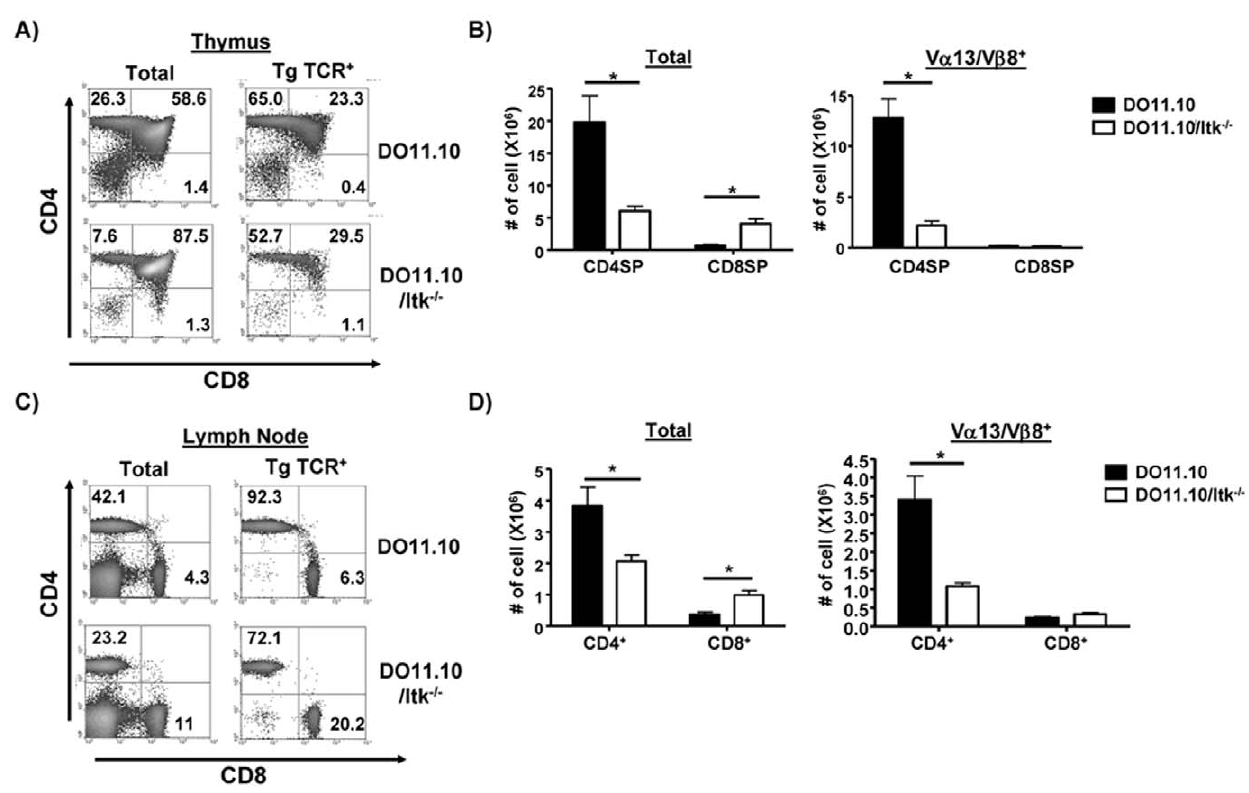
Figure 4. The absence of Itk affects the development of CD4 + T cells in DO11.10 transgenic mice. ( A ) Total thymocytes (left panels) or the transgenic TCR + (KJ-11 + ) population from DO11.10 and DO11.10/Itk 2 / 2 mice analyzed for expression of CD4 and CD8 (right panel). ( B ) The number of thymocytes (total, left) or transgene TCR hi thymocytes (right) in WT and Itk 2 / 2 mice. *p , 0.05, n=3–5 mice. ( C ) Total lymphocytes (left panel) or the transgenic TCR + population (right panel) from cervical lymph nodes of DO11.10 and DO11.10/Itk 2 / 2 mice analyzed for expression of CD4 and CD8. (D) The number of total lymphocytes (left) or the transgene TCR + T cells from cervical lymph nodes (n=3–5, *p , 0.05).